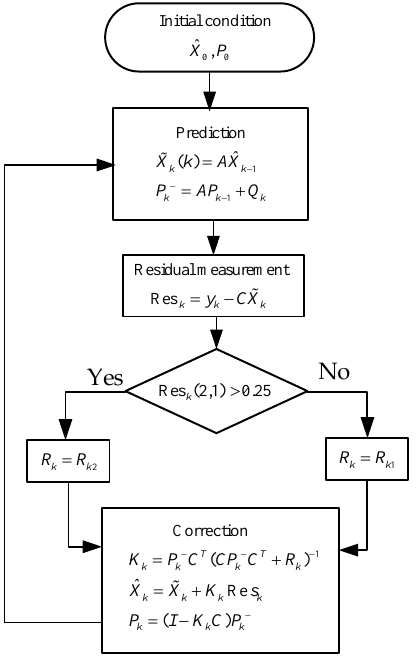
Figure 10. The fault detection and exclusion (FDE) structure for non-coherent pre-filter.